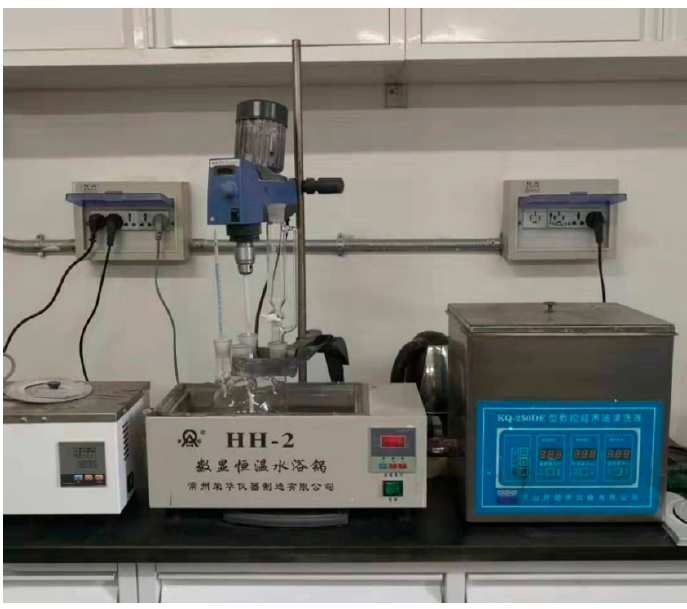
· n H 2 2 O nanoparticles